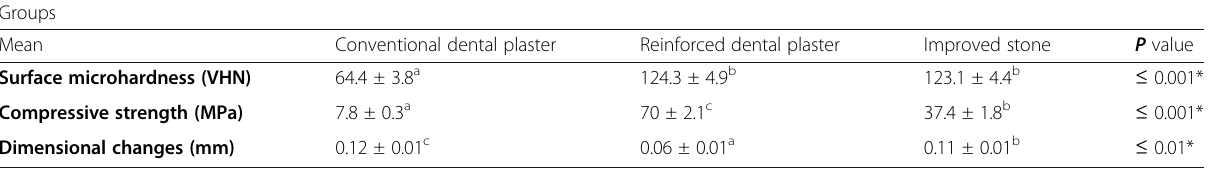
Table 2 The mean, standard deviation values and results of one-way ANOVA and Tukey ’ s HSD test for comparison between surface microhardness, compressive strength, and dimensional changes of the groups